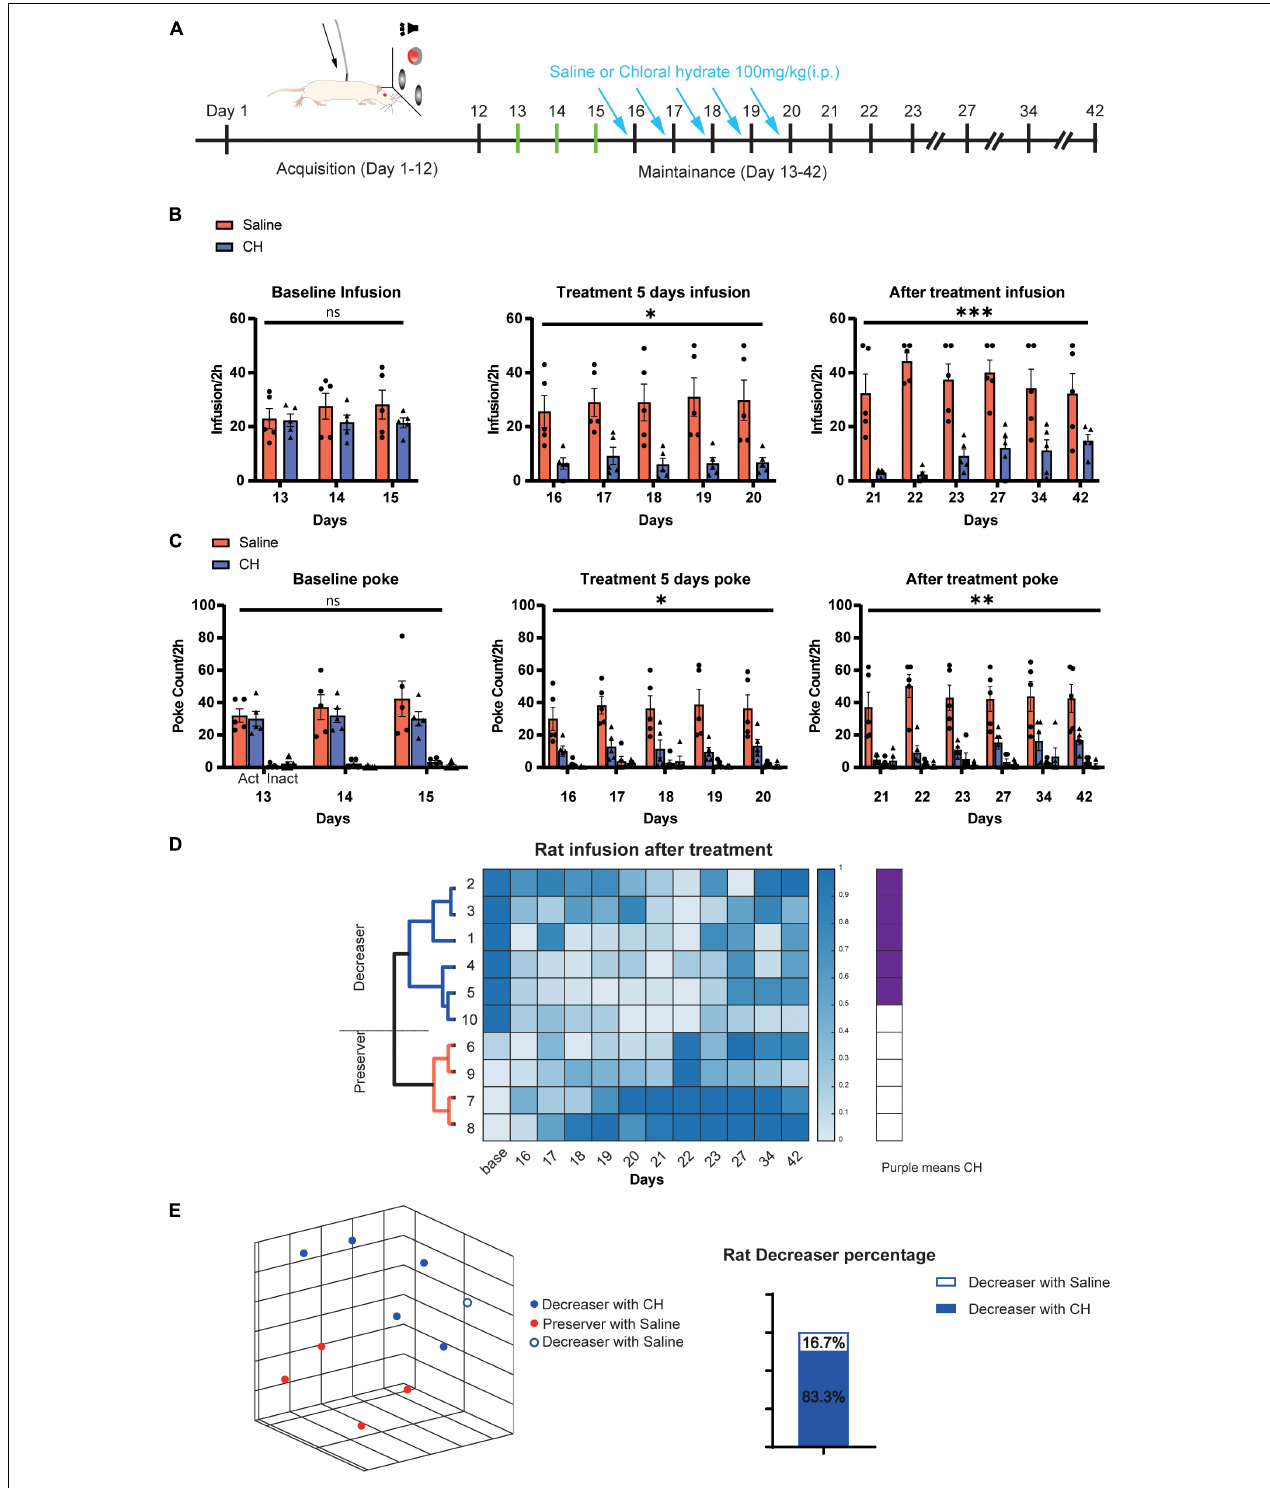
FIGURE 2 | Chloral hydrate reduces drug-seeking behavior in Meth self-administration. (A) Representation of rat self-administration schedule. (B,C) Chloral hydrate reduced drug-seeking behaviors ( N = 5 in the CH100 group, N = 5 in the saline group). (D) Hierarchical cluster based on uniform manifold approximation and projection (UMAP) of different parameters of maintenance session of Meth SA. Purple means CH100 treatment rats. The dark and light blue colors represent the normalized number of the infusion count. (E) The representation of three-dimensional UMAP clusters of decreaser (cluster blue) and preserver (cluster red) after treatment in Meth SA. ∗ p < 0.05, ∗∗ p < 0.01, ∗∗∗ p < 0.001; two-way ANOVA.